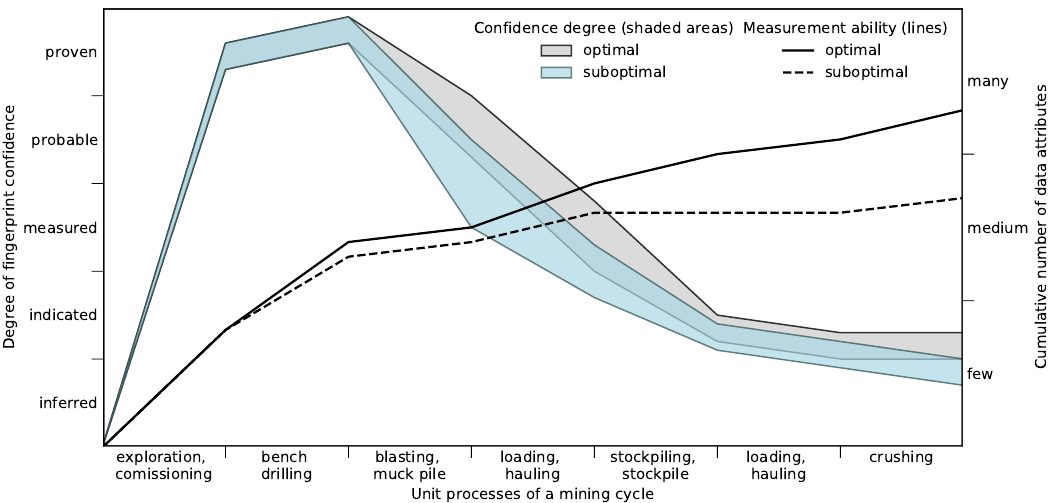
Figure 6. Indicative estimation of the degree of confidence in the fingerprint and the cumulative number of available data attributes throughout the mining cycle for two scenarios. The di ff erence can be found in the degree of optimality and relates to the capability of incorporating sensing